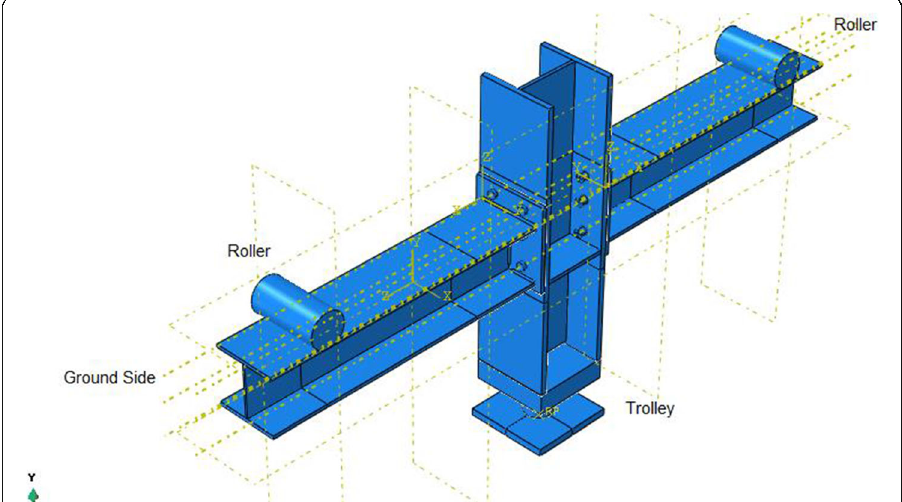
Fig. 10 Finite element model and boundary